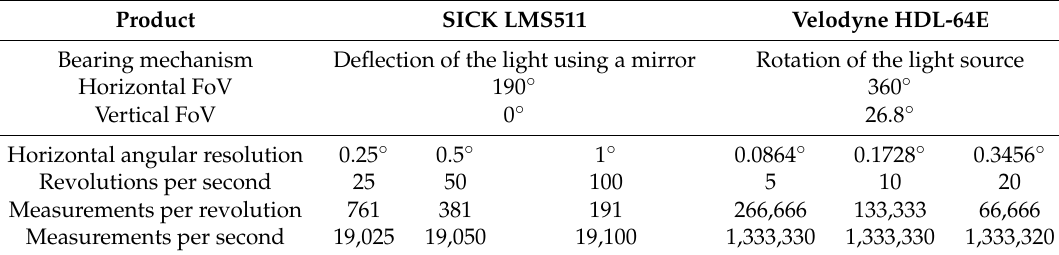
Table 1. Characteristics of two representative LIDAR products on the